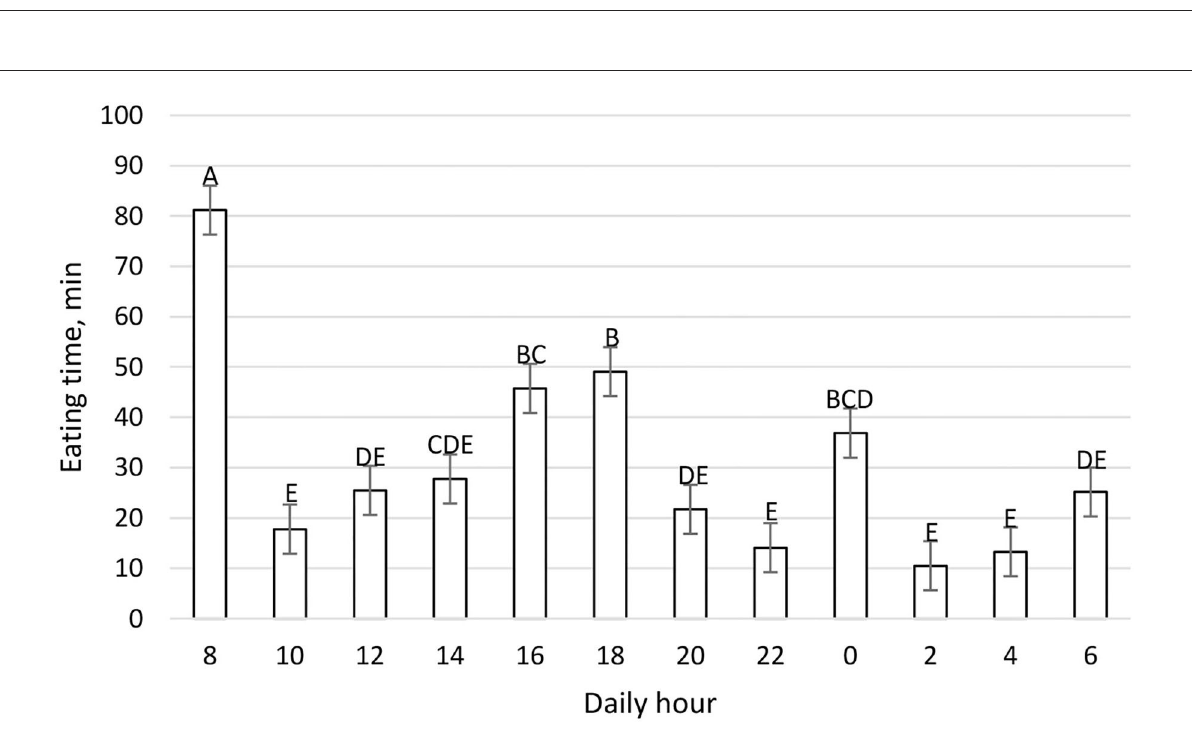
FIGURE3 Daily eating time (min) pattern (LSM ± SE) on a 2h basis during the fecal sampling period. Letters for differences ≤ 0.05. Each time point refers to 2h eating time. P-value < 0.01; SEM =